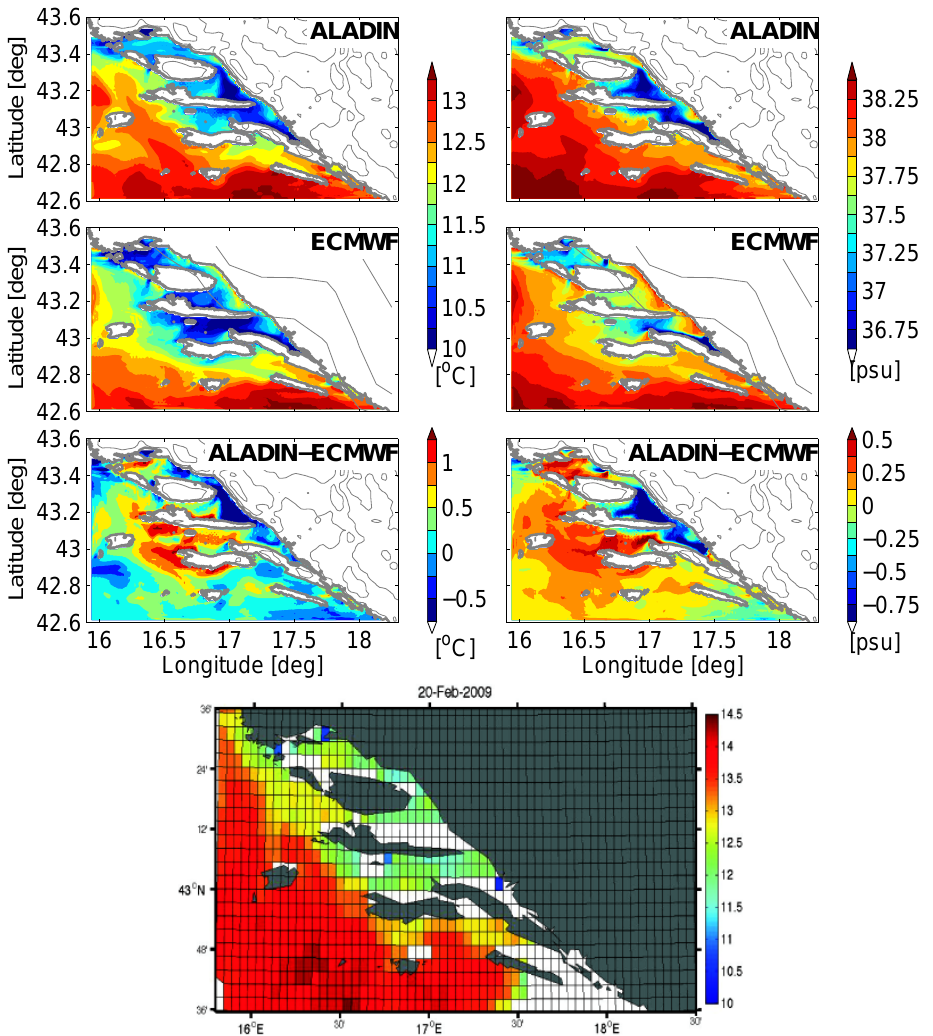
Fig. 6. Mean ASHELF-2 modeled sea surface temperatures (left panels) and surface salinities (right panels) for the B2 Bora period (Table 1) obtained by ALADIN and ECMWF forcing (upper two rows) and the differences between these two (third row). The lowermost panel shows the satellite-measured sea surface temperature for 20 February 2009.